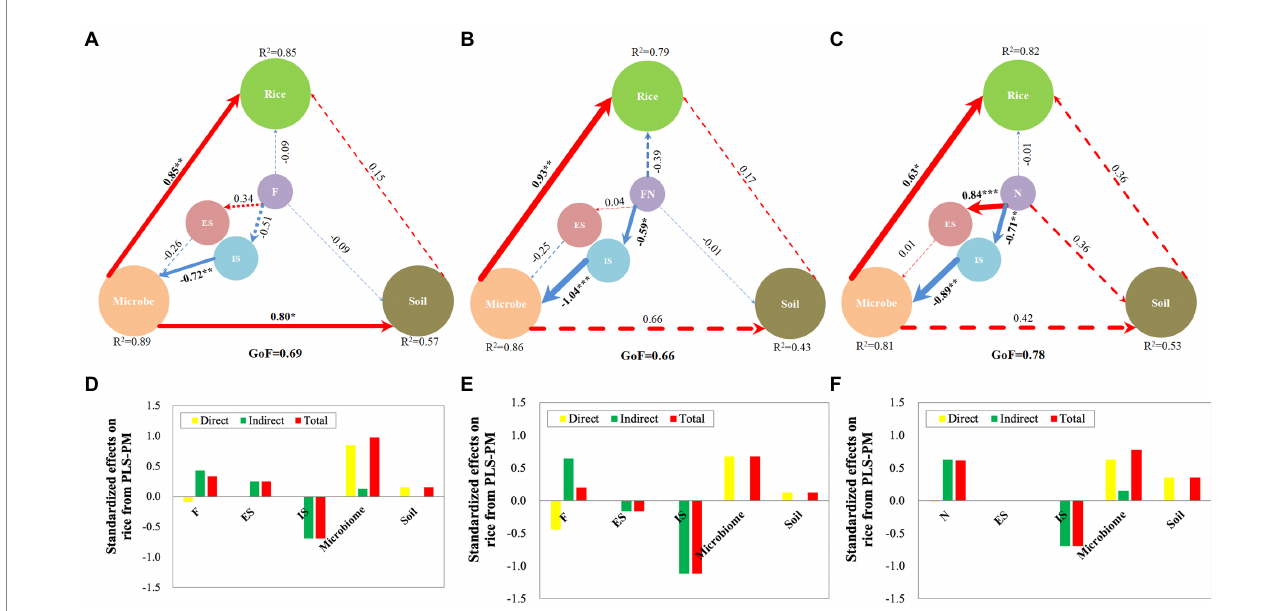
FIGURE 7 Partial least-squares path model (PLS-PM) in different treatments. (A) PLS-PM of F treatment; (B) PLS-PM of FN treatment; (C) PLS-PM of N treatment; (D) Effects on rice from PLS-PM of F treatment; (E) Effects on rice from PLS-PM of FN treatment; (F) Effects on rice from PLS-PM of N treatment. PLS-PM describing the relationships among microbial inoculants, enriched species (ES), inhibited species (IS), microbiome and soil with respect to rice in different treatments. Larger path coefficients are shown as wider arrows, and red and blue colors indicate positive and negative effects, respectively. Path coefficients and coefficients of determination ( R 2 ) were calculated after 999 bootstraps, and significance levels are indicated by *( p < 0.05), **( p < 0.01), and ***( p < 0.001). Models with different structures were assessed using the Goodness of Fit (GoF) statistic, a measure of the overall prediction performance. F, inoculated with B. velezensis FH-1; N, inoculated with B. diminuta NYM-3; FN, inoculated with B. velezensis FH-1 and B. diminuta NYM-3; ES, enriched species; IS, inhibited